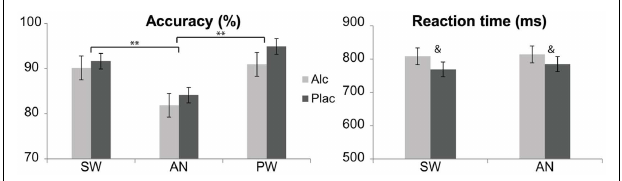
FIGURE 1 | Performance measures (means ± SE) reflected in accuracy and speed of reaction across alcohol and placebo. Only the standard words (SW) and imperative “animal” stimuli (AN) required a response, whereas responses were withheld to pseudowords (PW).The subjects responded least accurately to AN.While accuracy was only marginally affected by alcohol, RTs were increased by alcohol intoxication overall as indicated by a main effect of beverage. ** p < 0.001; & p <